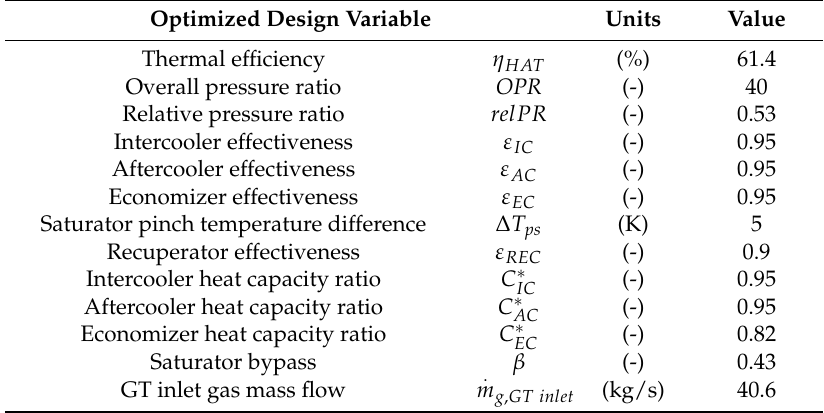
with maximum thermal 5